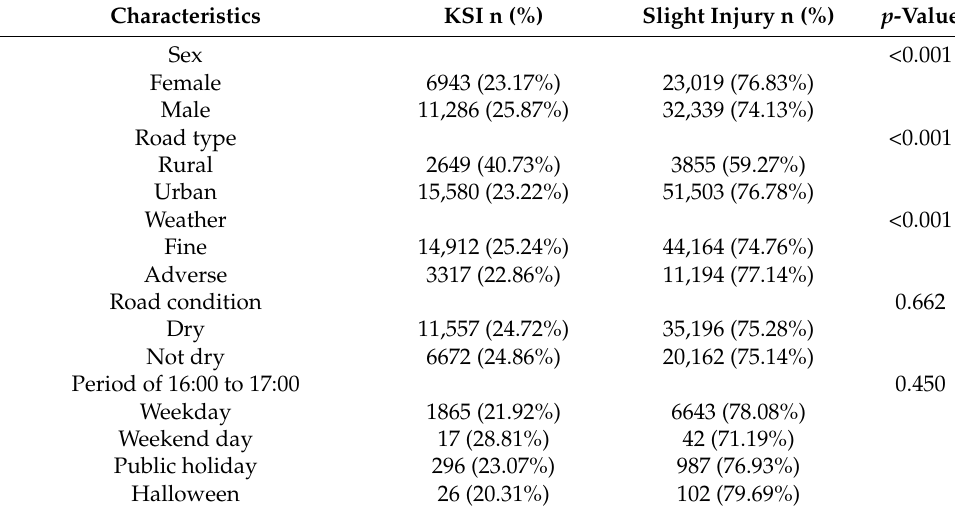
Table 2. Distribution of injury severity by risk factor during 1990 to 2017.